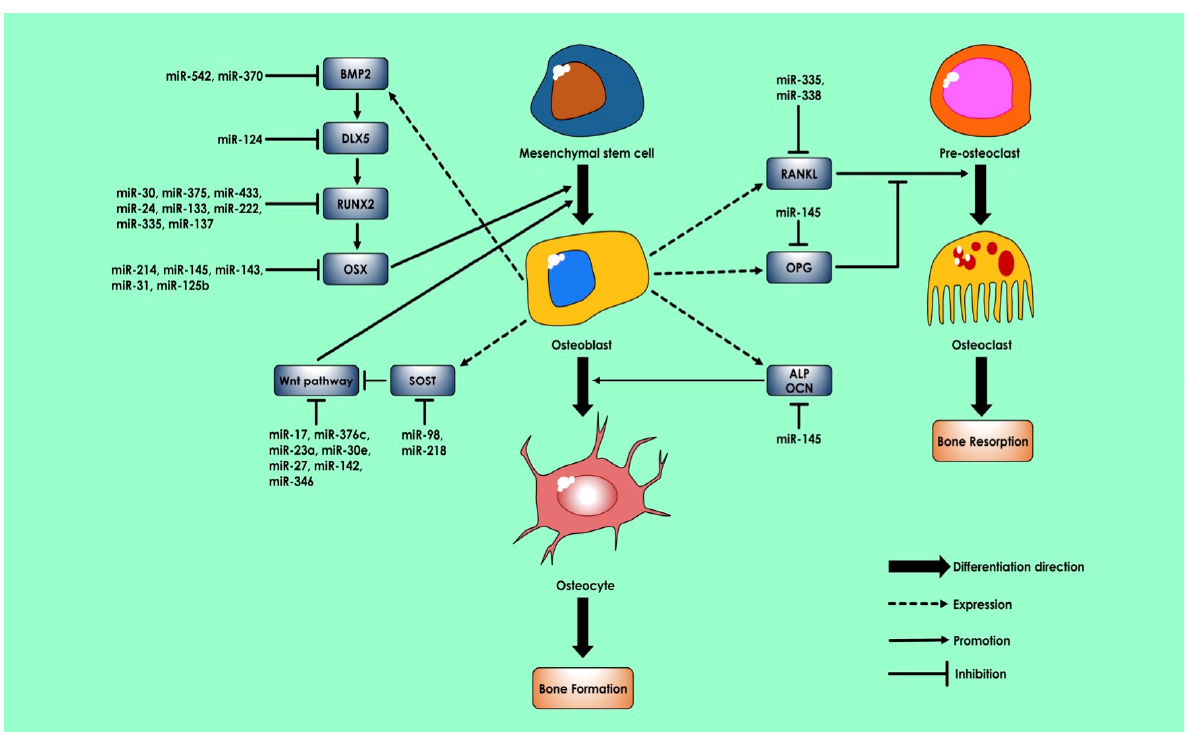
Figure 2. Regulation of bone formation by miRNAs. Various miRNAs play a regulatory role (activation or inhibition) in the differentiation of mesenchymal stem cells towards the formation of bone cells such as osteoblasts and osteocytes. The miRNAs regulate various molecules involved in signaling pathways, like Wnt, BMP2, DLX5, RUNX2, OSX, RANKL, SOST, and OPG, in osteogenesis (bone formation) and osteoclastogenesis (bone resorption).